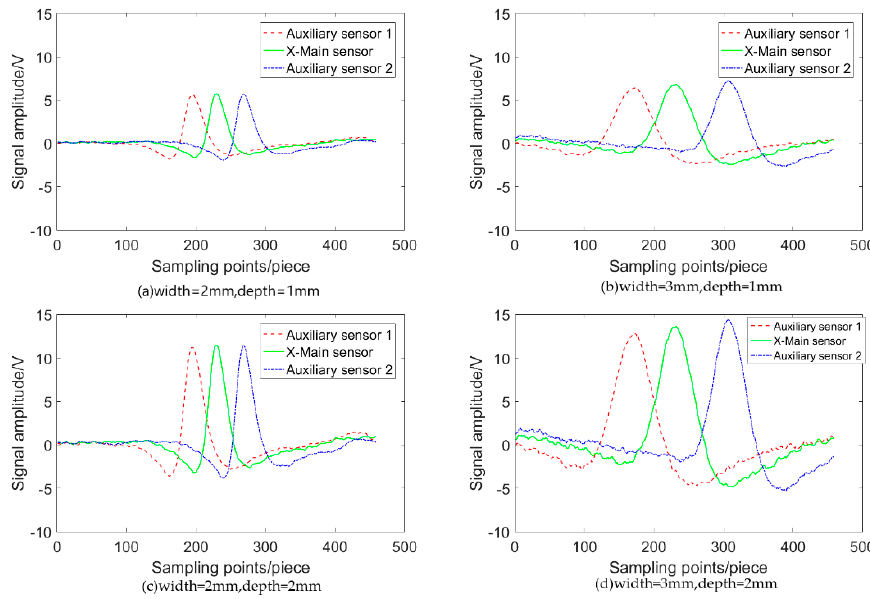
Figure 13. x -component results with different defects.